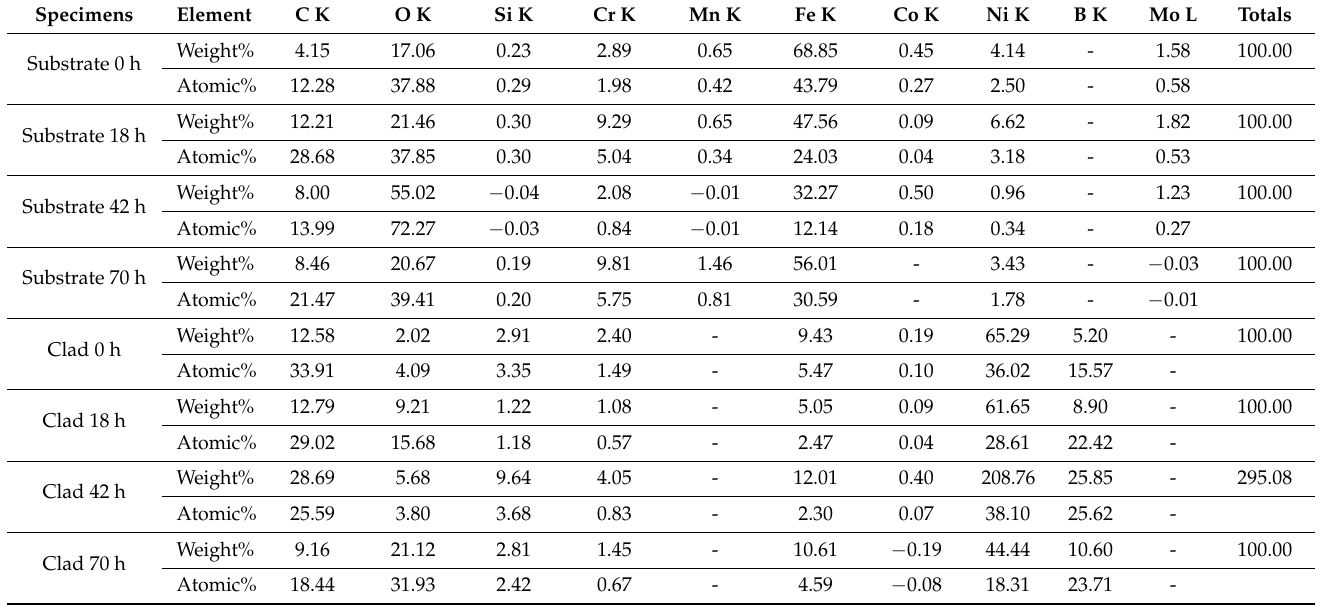
Figure 9. Schematic illustration of passivation layer formed on the clad layer ( a ) Colmonoy-6 clad layer, ( b ) Reaction of Cr, C, B ions present in the Colmonoy-6 with oxygen ions, ( c ) Formation of passive film on the Colmonoy-6 layer which resists corrosion, and ( d ) Fragile passive patches start to leave from the surface.